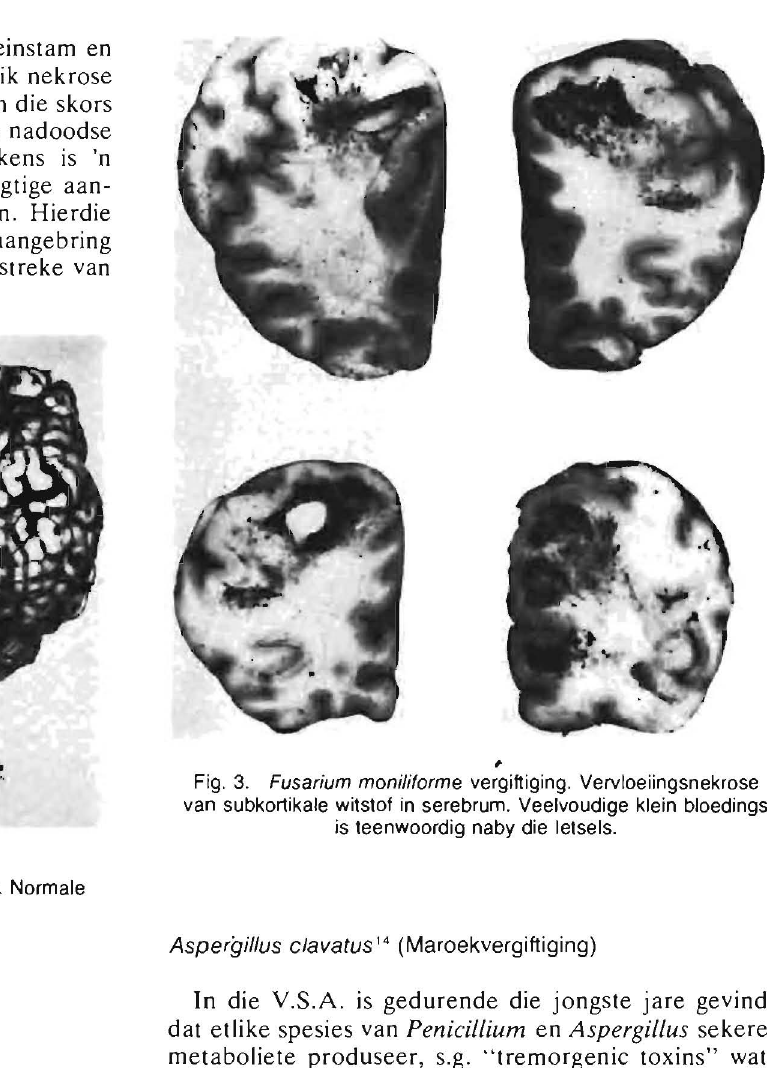
In die V.S.A. is gedurende die jongste jare gevind dat etlike spesies van Penicillium en Aspergillus sekere metaboliete produseer, s.g. "tremorgenic toxins" wat spiertrilling, konvulsies en die dood kan veroorsaak. Hierdie werk was tot dusver beperk tot laboratorium